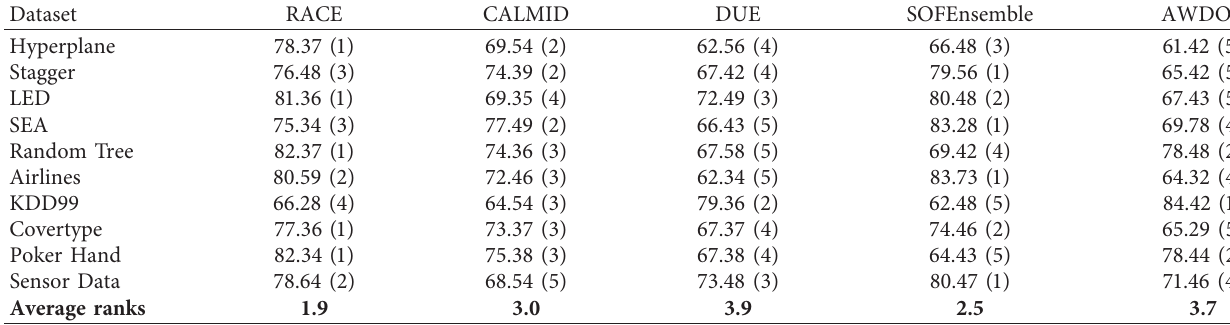
Table 4: Kappa M values for all the ten